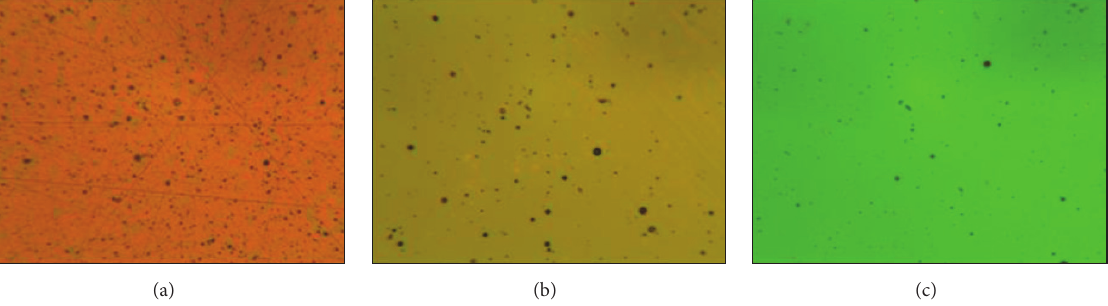
Figure 1: Optical micrographs (40x) of the films prepared with irradiation times of (a) 2.5 min (b) 7.5min, and (c) 10min.